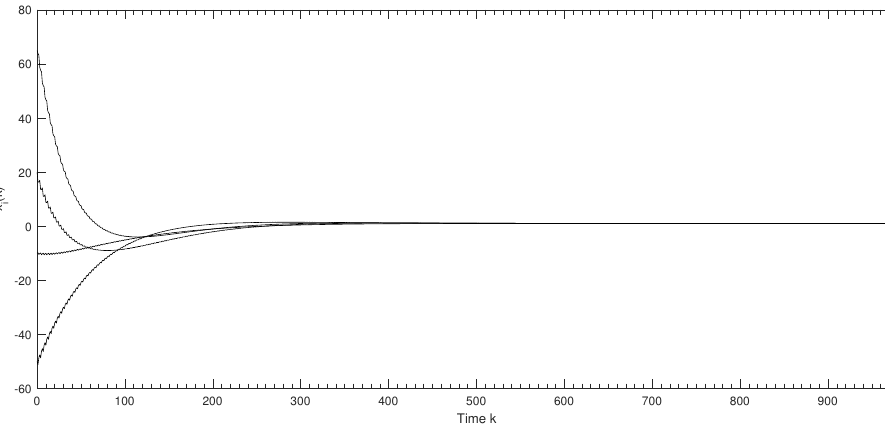
Figure 5. State trajectories of four agents in the case of switching topology and h = 0.01.